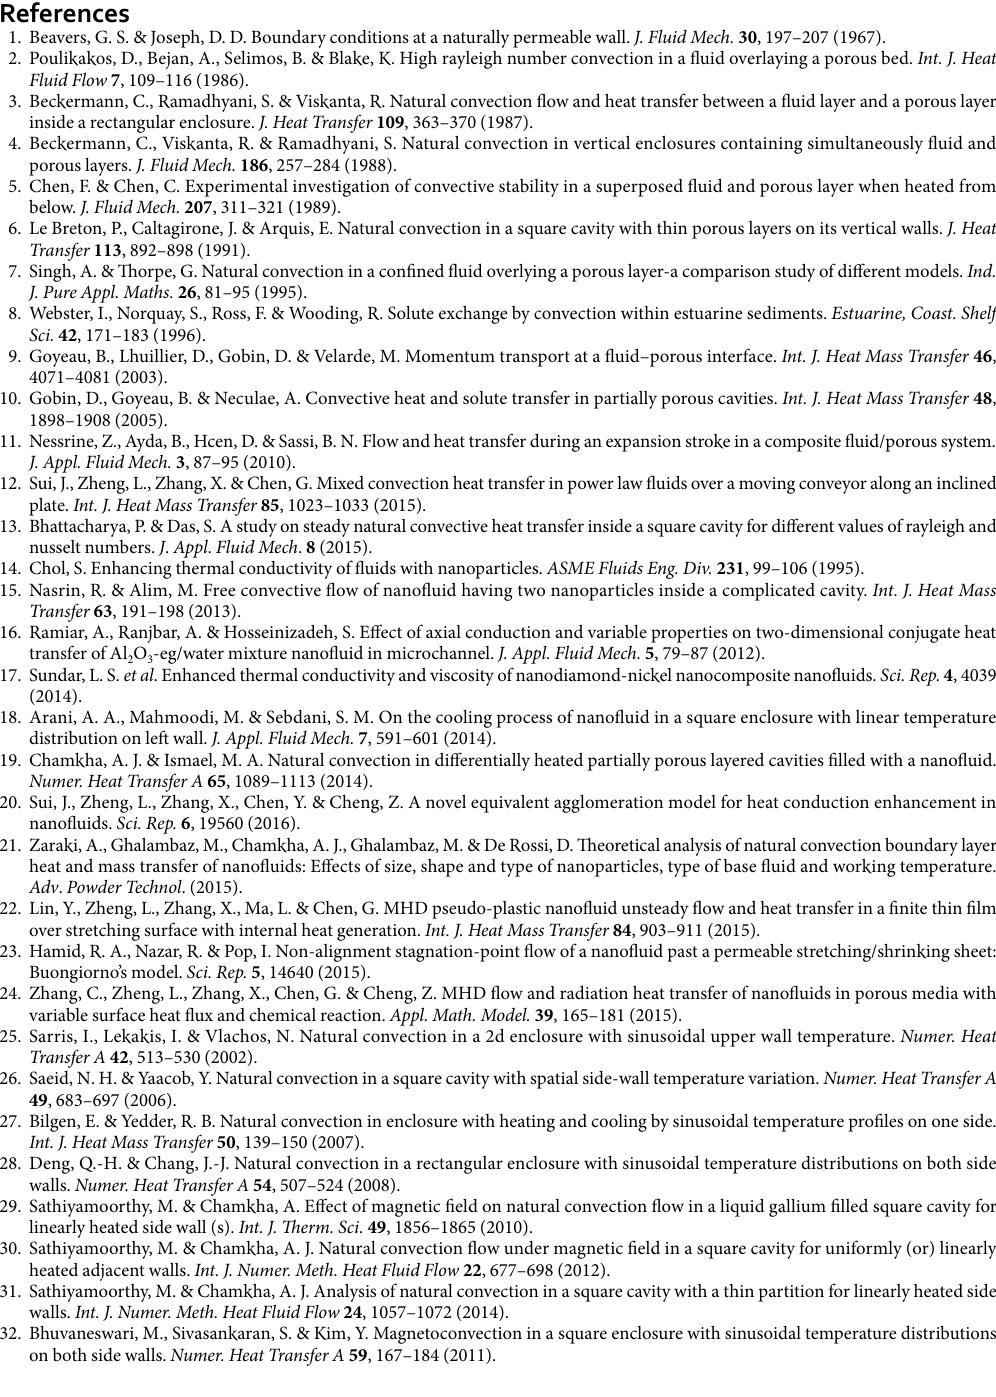
downwards which results in the local Nusselt number to form a sinusoidal shape caused by the phase devi- ation enhancement. and the reduction of average Nusselt number are indicated by the fixed inclination angle. 5. At low porous layer thickness, Ag appears with a higher enhancement in the heat transfer rate